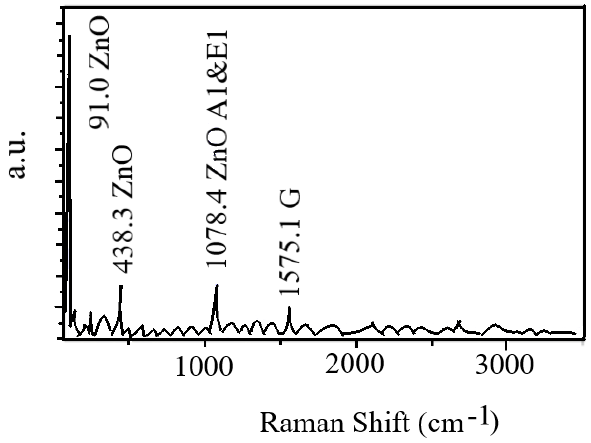
Figure 10: Raman spectra of the ZnO-1.4 wt% hybrid after thermal treatment in air at 450 ∘